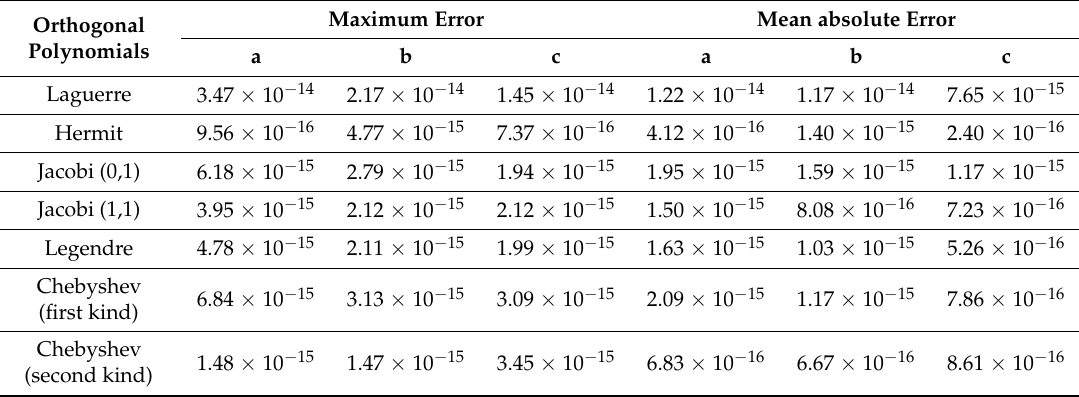
Table 1. Maximum and mean absolute errors for Example